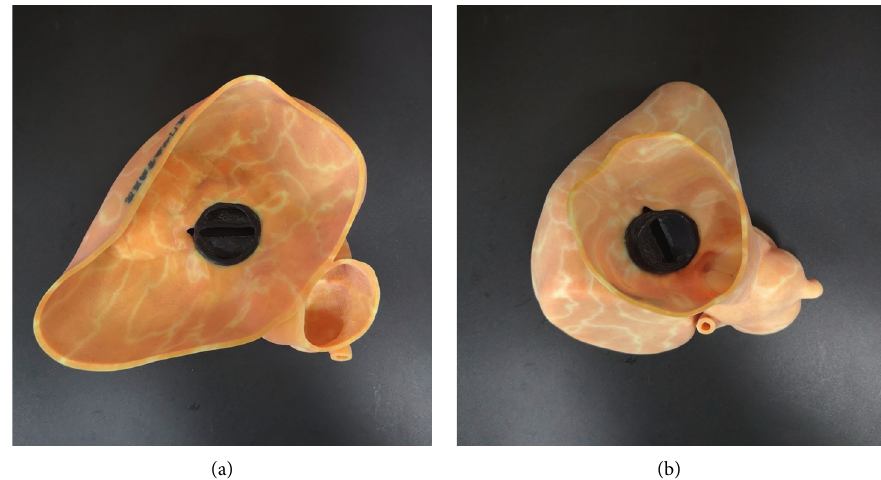
Figure 2: A 3D printing model clearly shows the location and surrounding structures of mitral paravalvular leakage.